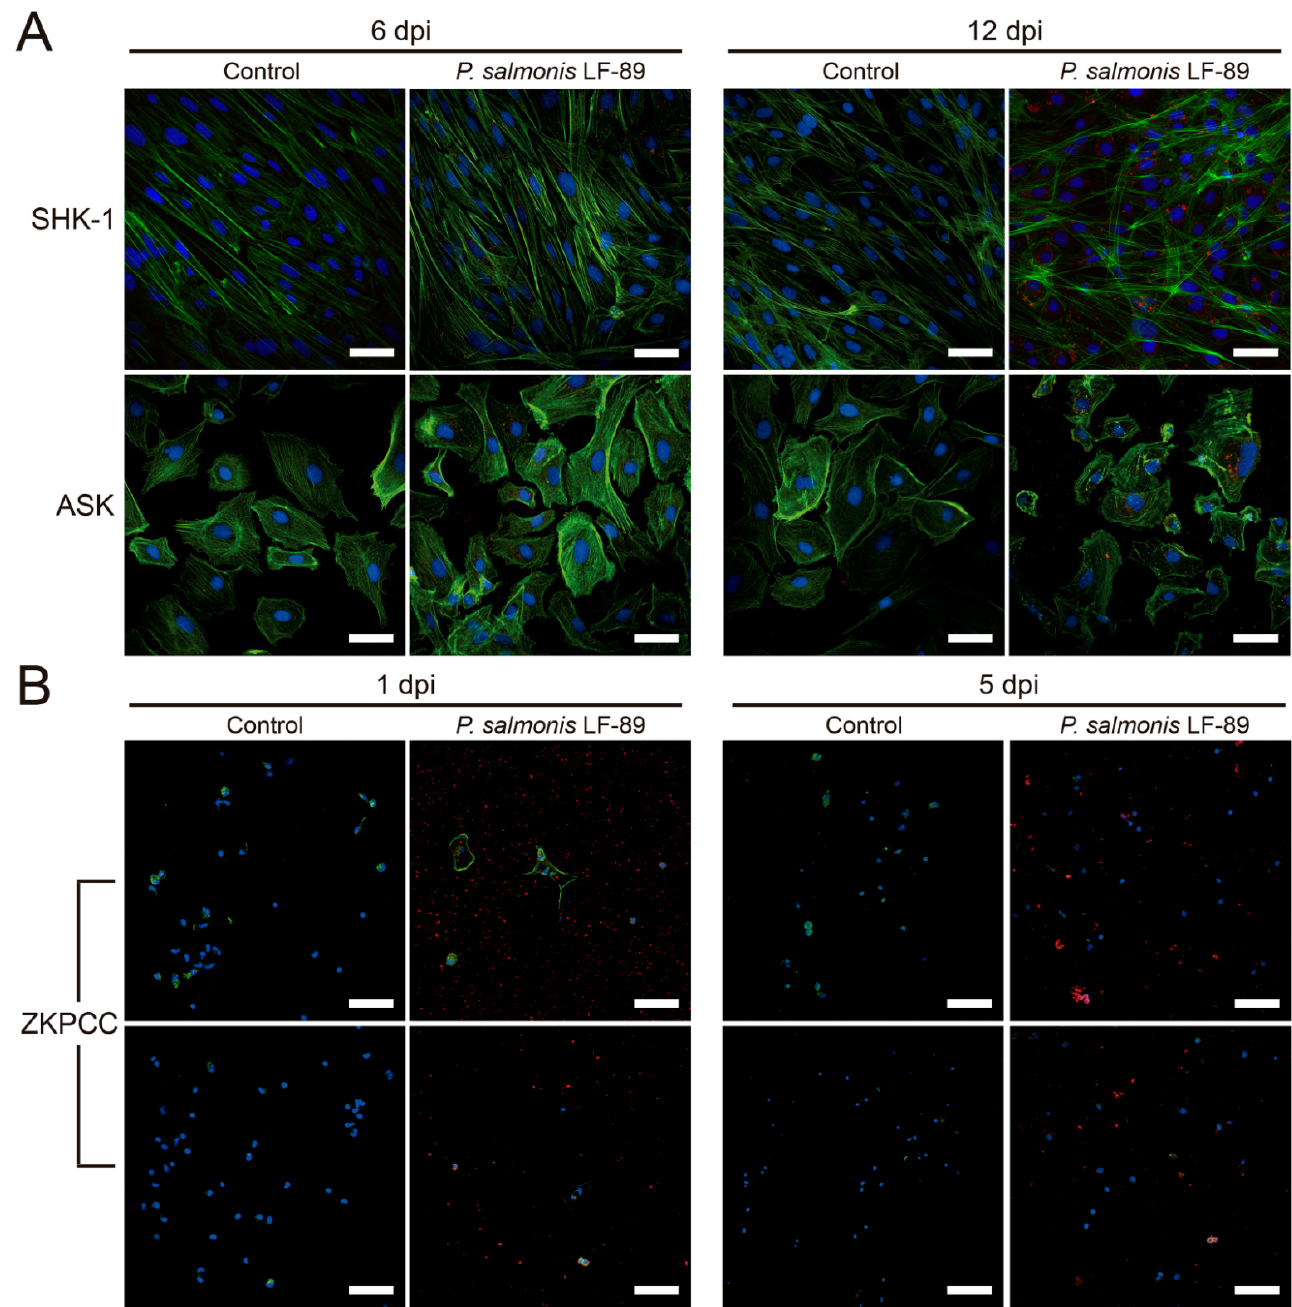
Figure 5. Immunofluorescence microscopy of P. salmonis -infected salmon cell lines and zebrafish primary cell cultures. ( A ) P. salmonis -infected and mock-infected (control) salmon cell lines SHK-1 and ASK were fixated before fluorescence staining after 6 and 12 dpi. ( B ) P. salmonis -infected and mock-infected (control) zebrafish primary cultures (ZKPCC) were fixated after 1 and 5 dpi. Both panels show representative images of zebrafish cells with different cell types. For the three cultures, cellular actin was stained with phalloidin in green (Alexa Fluor 488 ® ), and the nucleus in blue with DAPI. Polyclonal antibodies against P. salmonis and a secondary antibody coupled with Alexa Fluor 594 ® marked the bacteria in red. Bar represents 50 µm. Images obtained at each channel are provided in Figure S3.